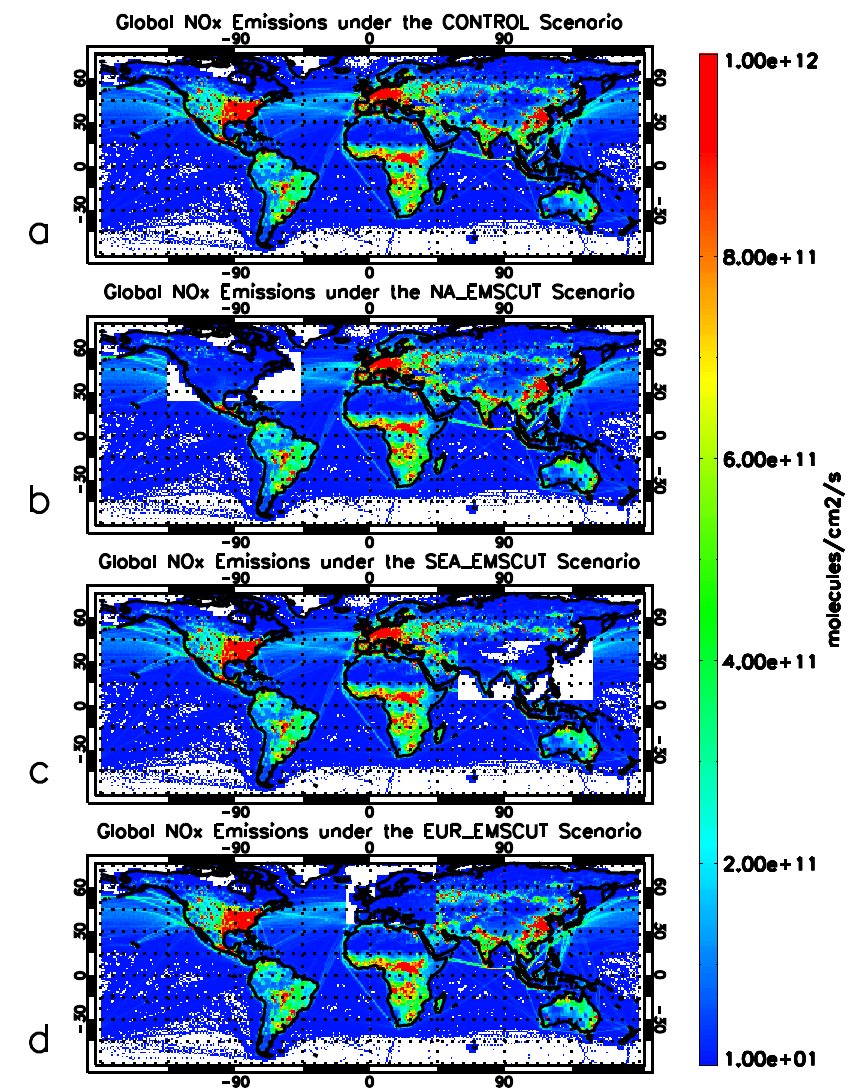
Fig. 2. Global surface NO x emission distributions under (a) the control and (b–d) each of the emissions cut